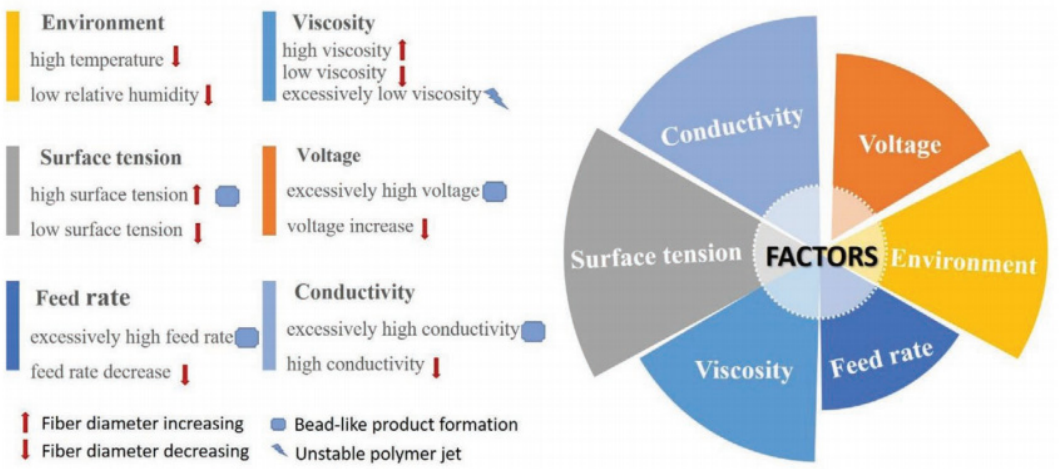
Figure 2. Factors affecting fiber formation during electrospinning [30].